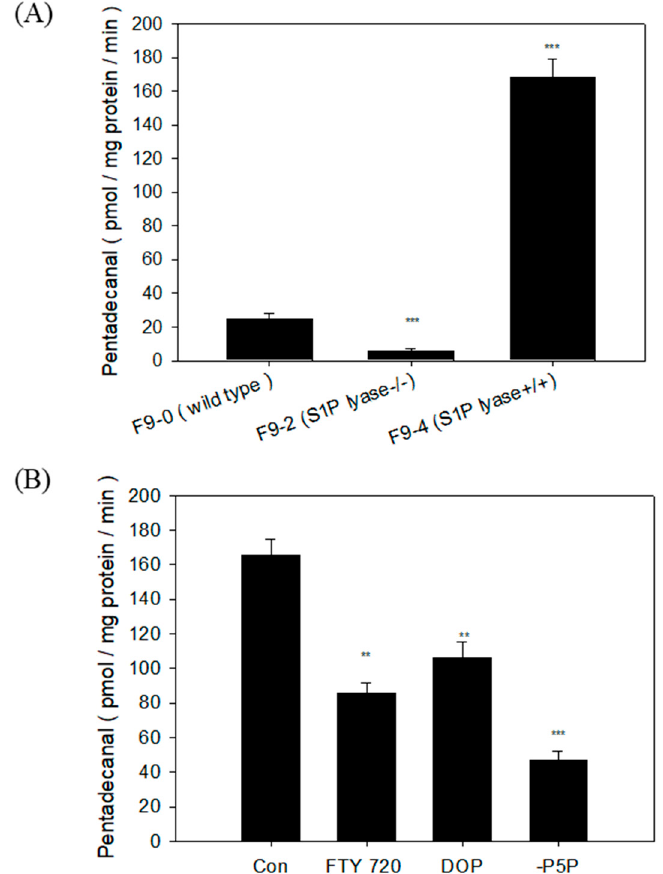
Figure 8. S1PL activity assay in the S1PL modification cell line. FTY720 and 4-deoxypyridoxine (DOP) inhibited S1PL activity in vitro. ( A ) S1PL reaction for 20 min with 20 µM C17-Sa1P as the substrate and 50 µg of F9-0 (wild type), F9-2 (S1PL − / − ), and F9-4 (S1PL +/+ ) cell lysates in the presence or absence of 0.57 mM pyridoxal-5-phosphate (P5P). ( B ) S1PL reaction in the presence or absence of 0.57 mM P5P with FTY720 (50 µM) or DOP (1000 µM). The data represent the mean ± SD of triplicate analyses. ** p < 0.01 and *** p < 0.001 compared to the F9-0 cell or control groups.